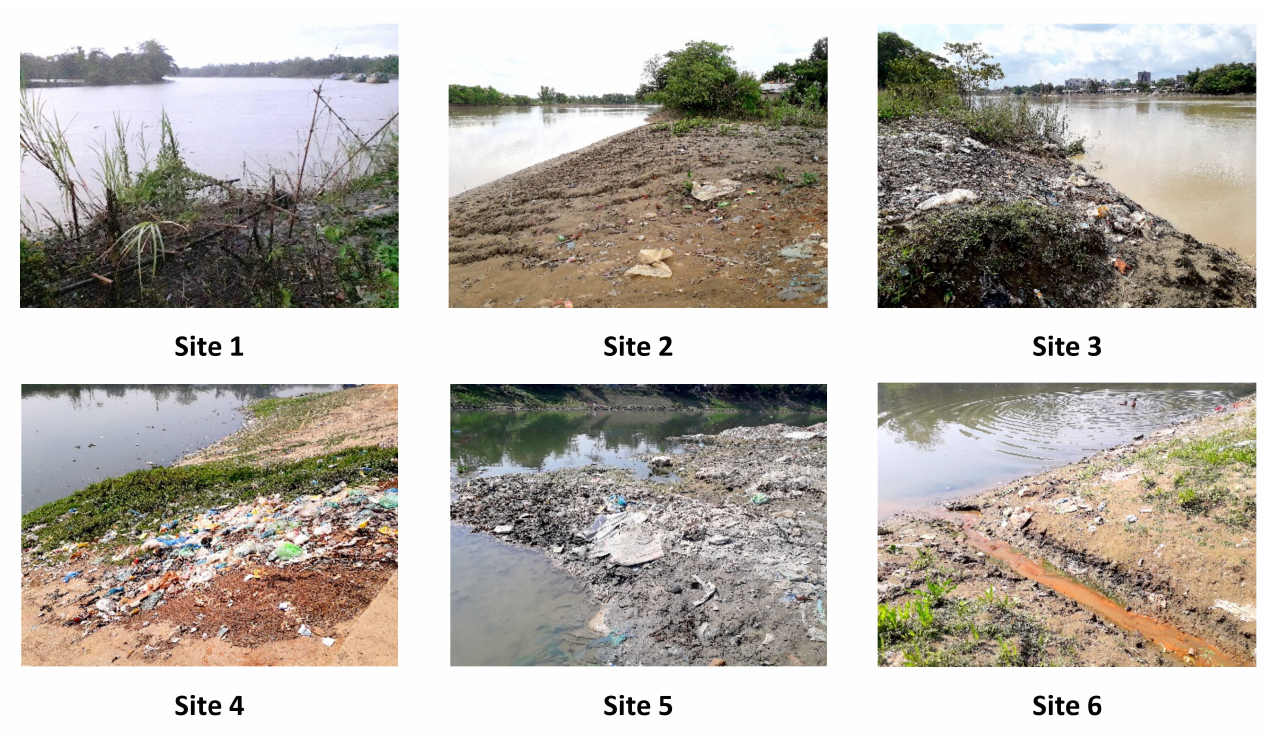
Figure 1. The geographical location of sampling sites selected for the current study (Site 1—Charkhai,